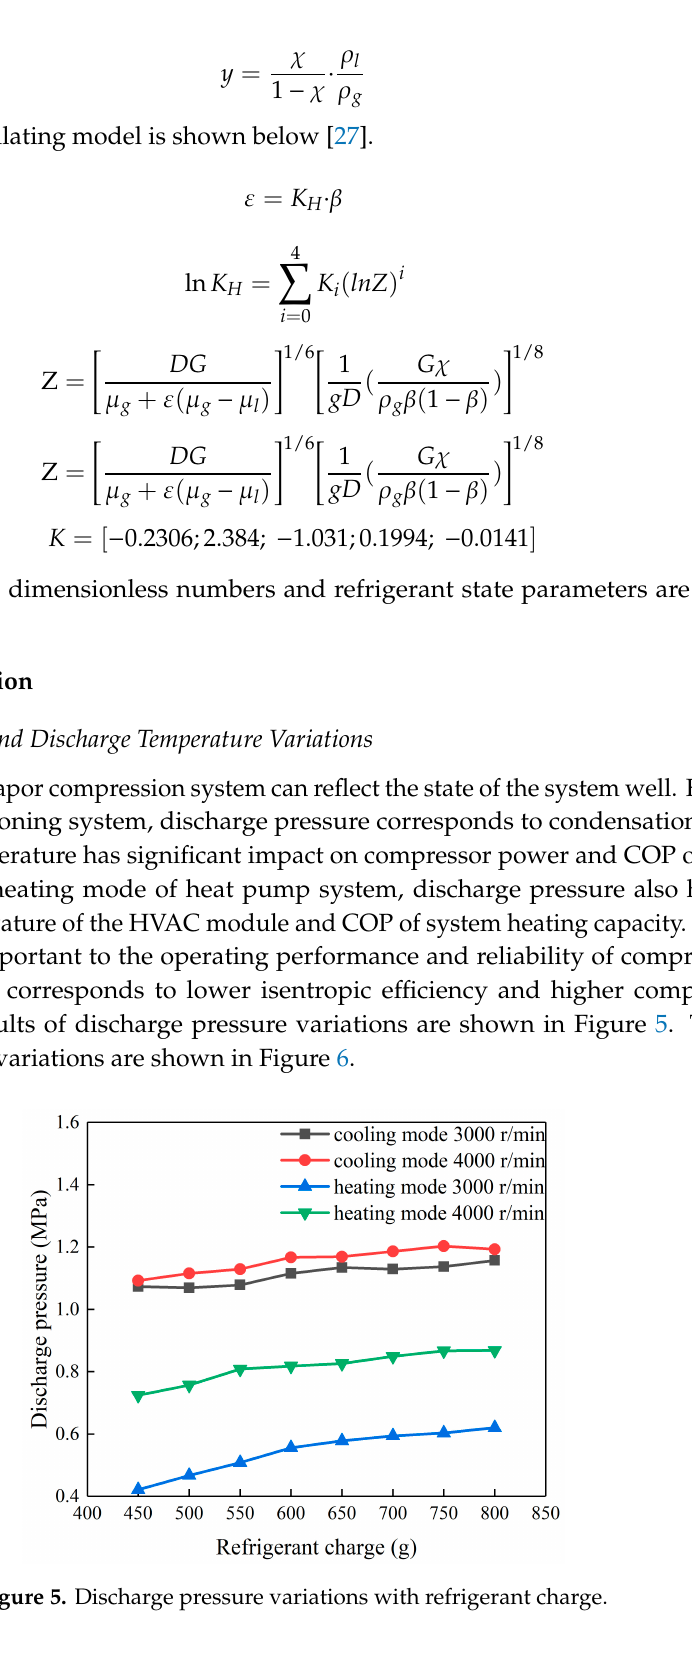
Figure 6. Discharge temperature variations with refrigerant charge.